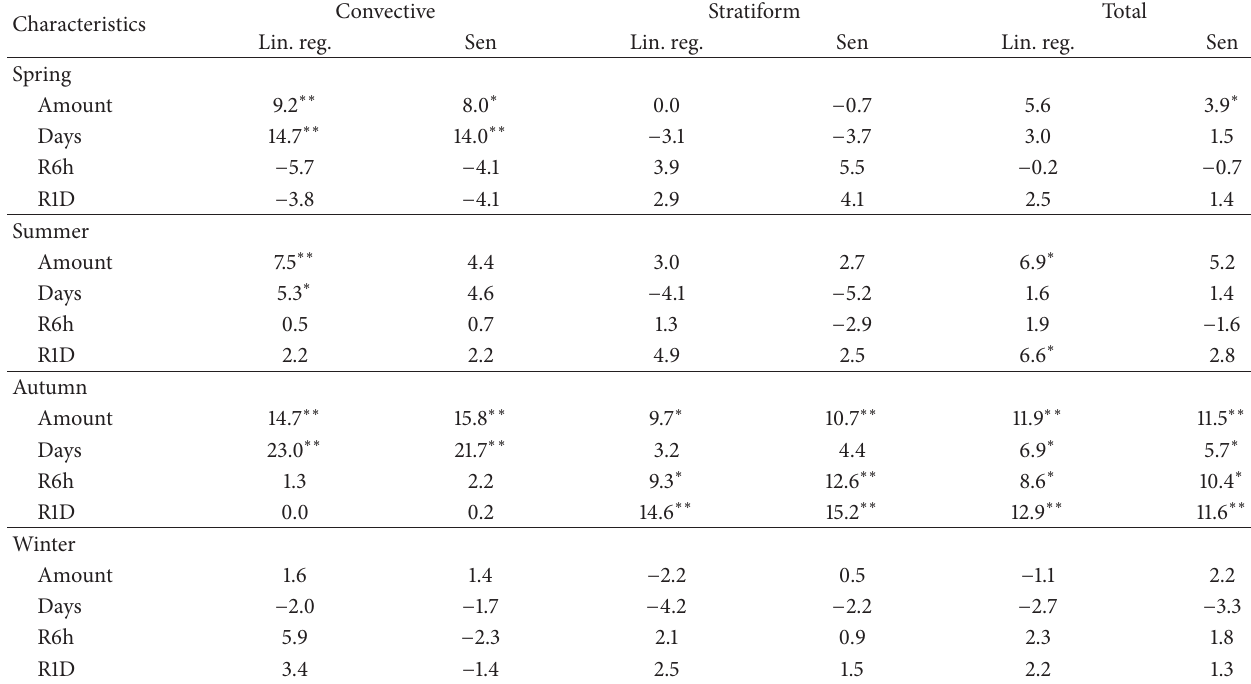
Table 2: Trend magnitudes (expressed as relative change of the examined characteristics in %/10 years) of average precipitation characteristics from all stations over 1982–2010. ∗ ( ∗∗ ) denotes trend significant at the 0.2 (0.1) level.